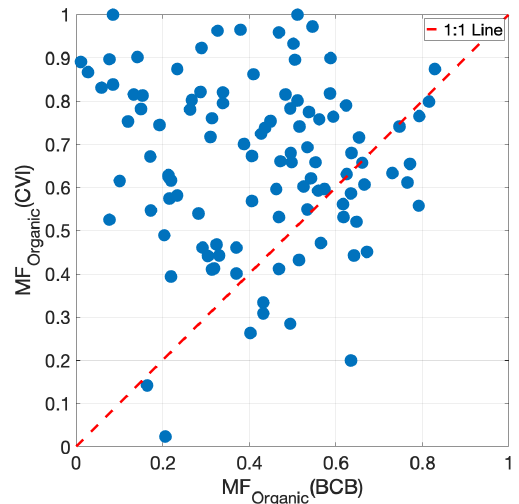
Figure 8. Scatterplot of organic mass fraction in droplet residuals (downstream CVI in cloud) and in aerosol sampled during the clos- est below cloud base (BCB) leg from ACTIVATE deployments 1– 4. A total of 25 points out of a total of 110 (23%) were below the 1 : 1